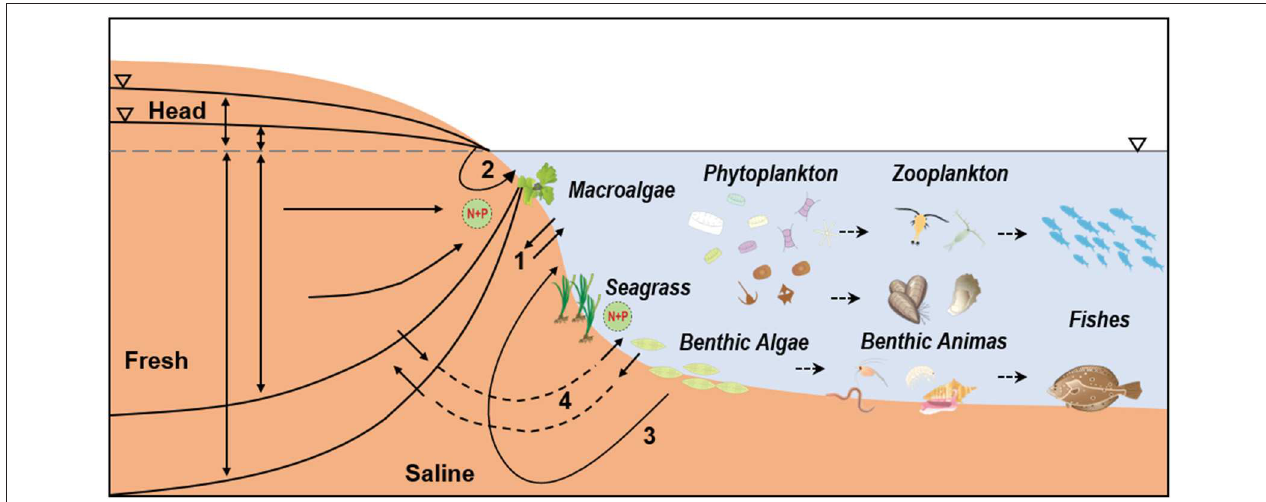
FIGURE 6 | Biological production in coastal ecosystems based on nutrients supplied through SGD. The numbers refer to the driving forces identified in Figure 2 .